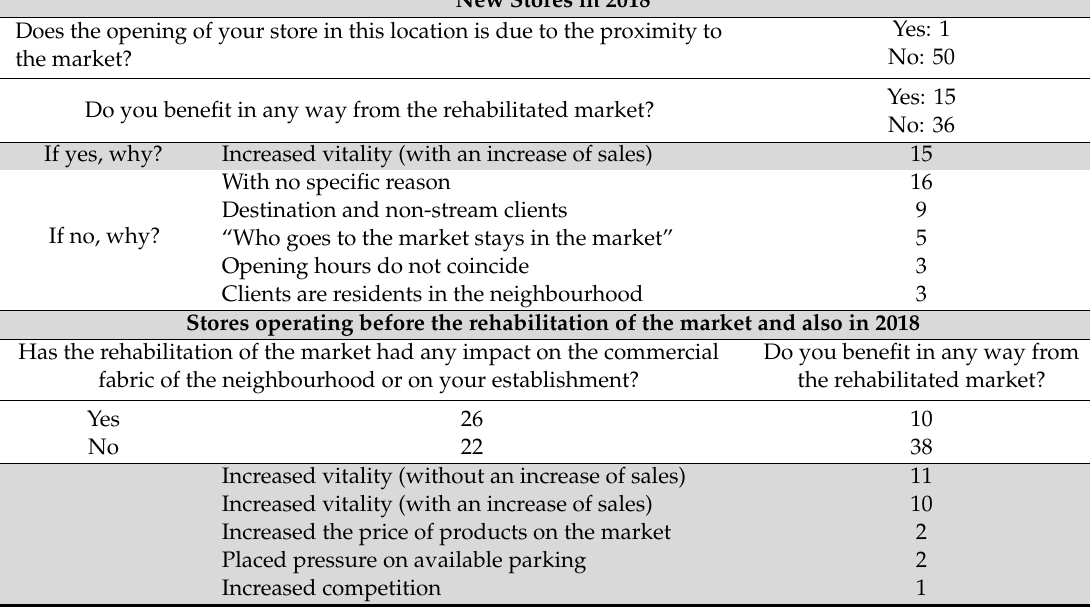
Table 2. Synthesis of interviews performed on